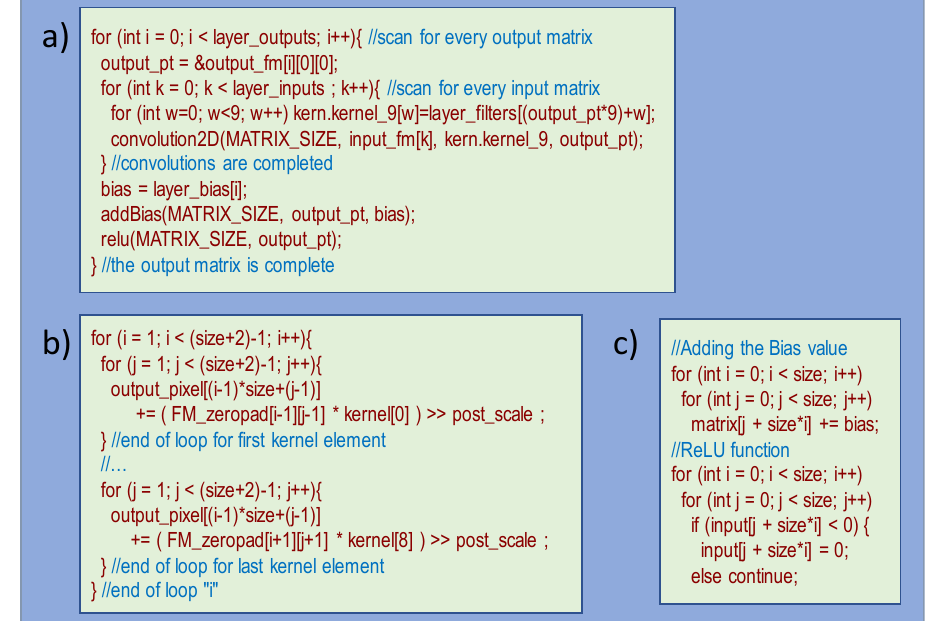
Figure 7. ( a ) Convolutional layer in generic C code; ( b ) Convolution2D function inner operations; ( c ) Bias addition and ReLU function inner operations (Layers: 1, 2, 4, 5, 7, 8, 9, 11, 12, 13, 15, 16, 17).